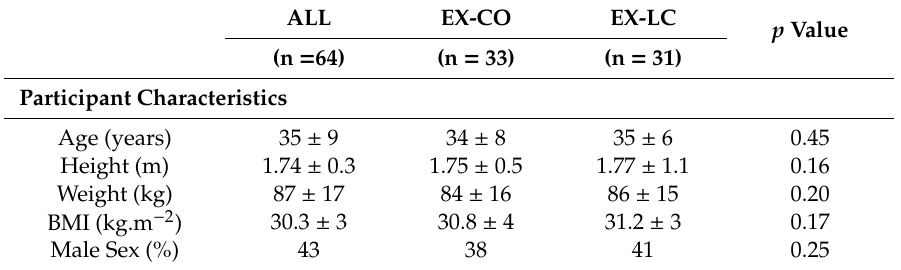
Table 1. Baseline participant characteristics of the complete cohort and comparisons between